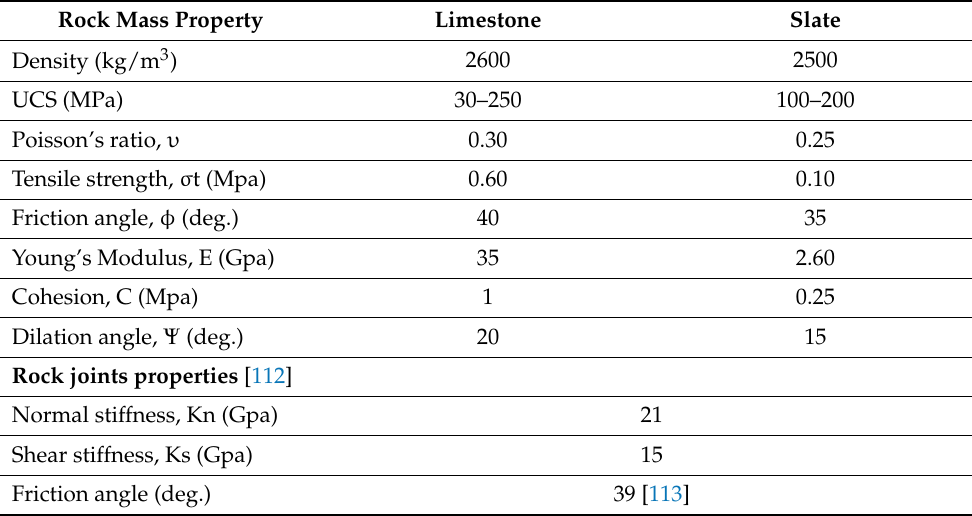
Table 2. Geomechanical properties of rock mass and joints [111,112]. Rock Mass